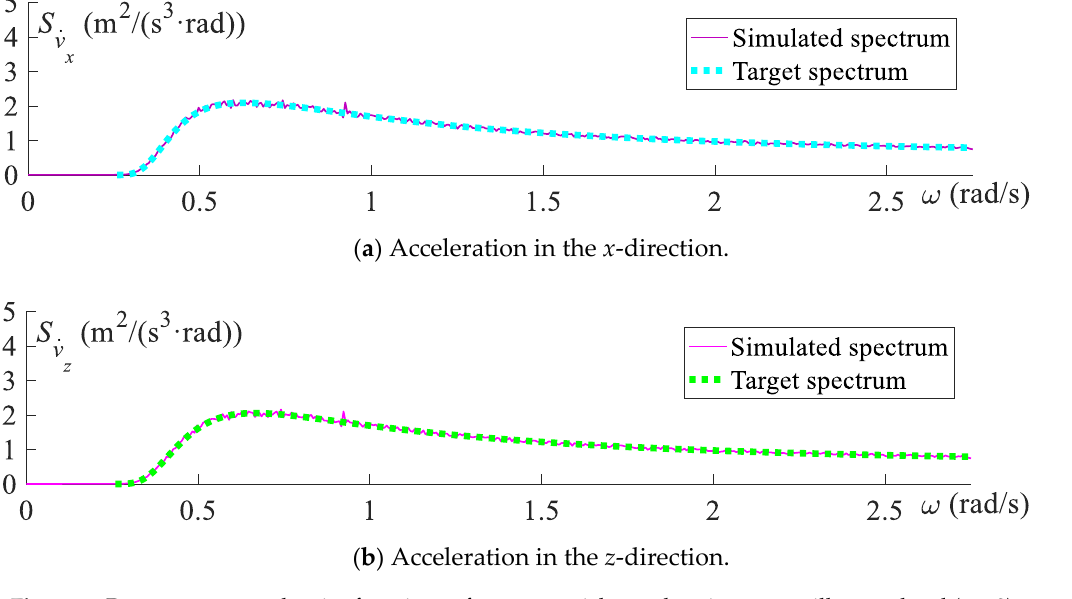
( a ) Acceleration in the x -direction.